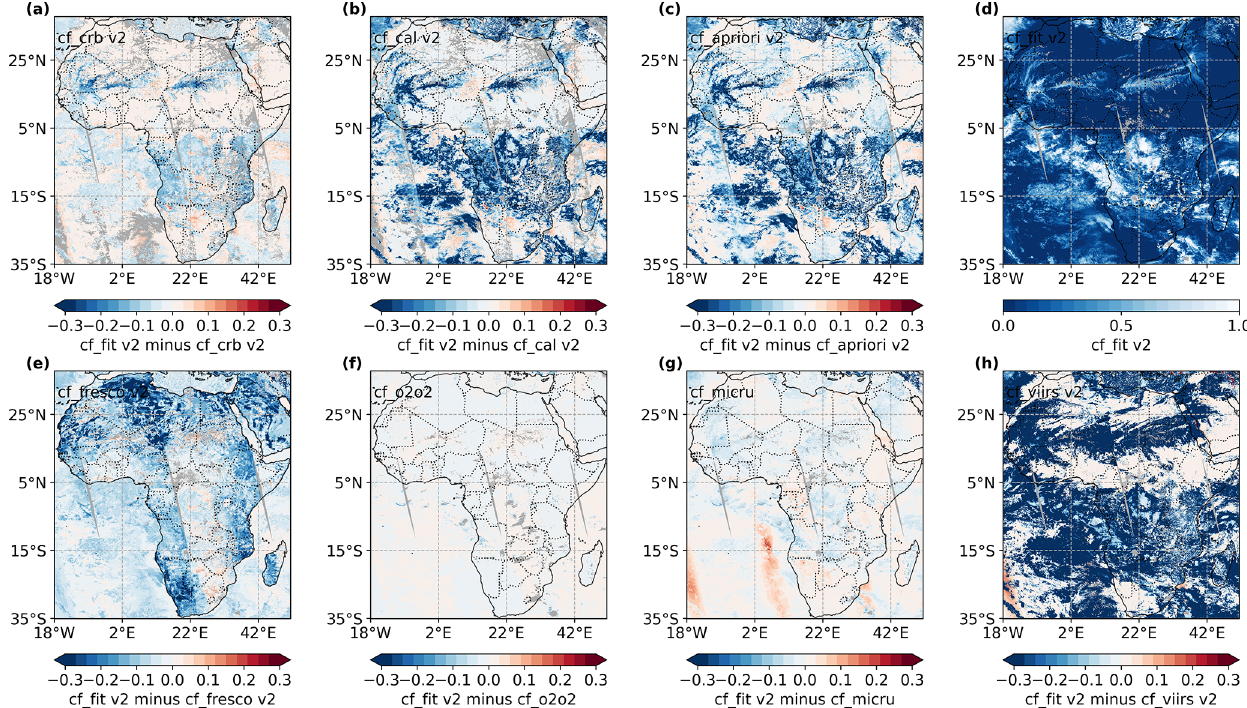
Figure 10. Differences between the version 2 cloud fractions from (a) ROCINN CRB, (b) ROCINN CAL, (c) OCRA a priori, (e) FRESCO, (f) O 2 –O 2 , (g) MICRU, and (h) VIIRS and the cloud fraction from the NO 2 fitting window (cf_fit) for Africa and the winter day (5 January 2019). Panel (d) shows the cloud fraction map of cf_fit over the Africa region for that